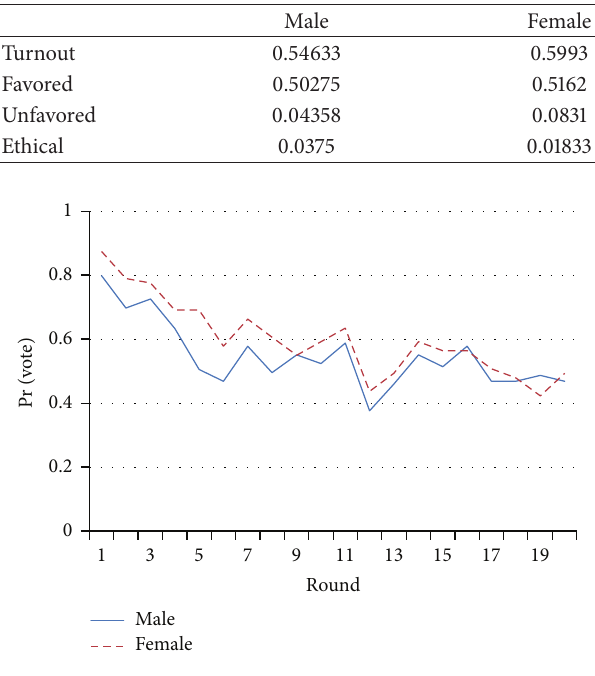
Table 9: Voting turnout rates by gender.